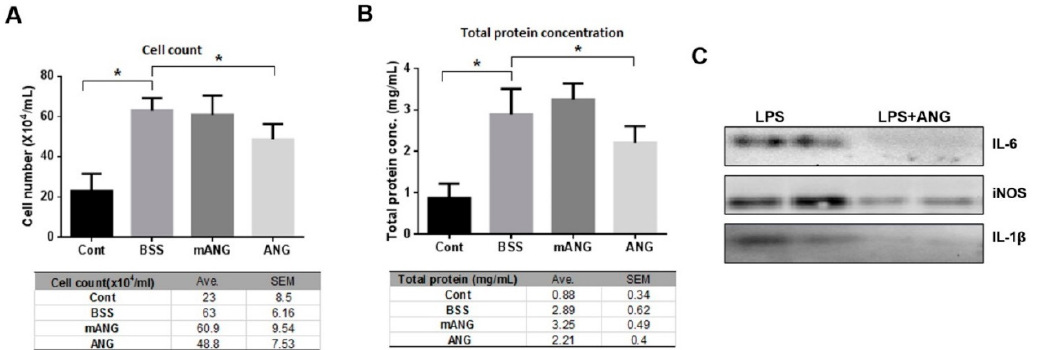
Figure 2. ANG attenuates inflammation in EIU. ANG attenuates inflammation in EIU. ( A ) Quantification of infiltrating cells in the anterior chamber. LPS induced EIU eyes showed significantly increased cell count compared to the normal LPS control. ANG treated eyes contained significantly lower numbers of infiltrating leukocytes in the anterior chamber (48.8 ± 7.53) compared to BSS or mANG treated eyes (63 ± 6.16 or 60.9 ± 9.54; both p < 0.05). ( B ) Quantification of infiltrating protein concentration in the anterior chamber. The total protein content was significantly lower in ANG treated eyes compared with LPS + BSS control eyes (2.21 ± 0.4 and 2.89 ± 0.62, respectively; both p